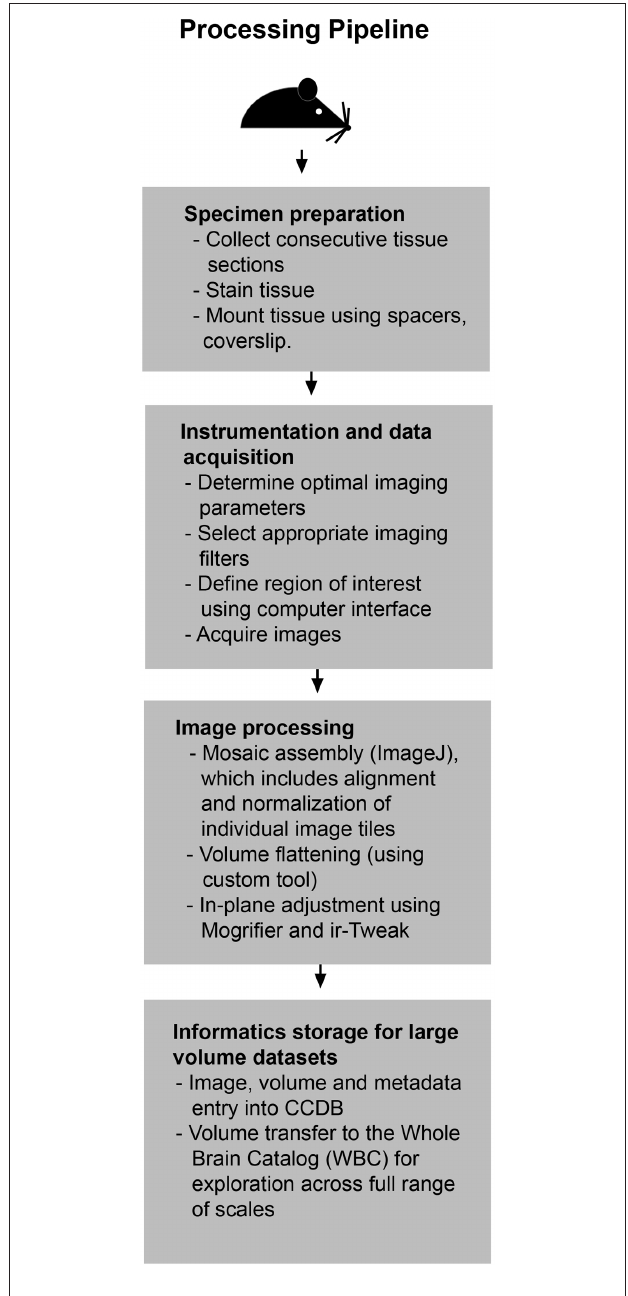
Figure 1 | Processing pipeline flowchart. This flowchart illustrates the steps required to generate a 3D reconstruction of serial large-scale brain mosaics starting with specimen preparation and ending with deposition of datasets into publicly available